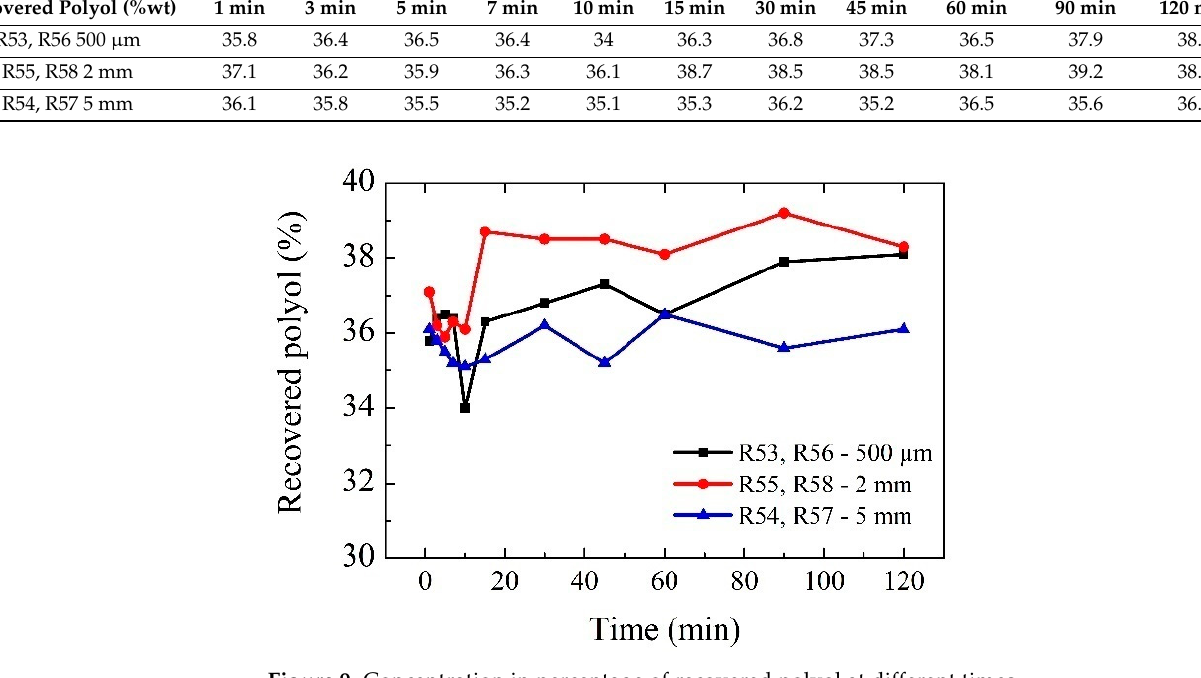
Figure 9. Concentration in percentage of recovered polyol at different times.